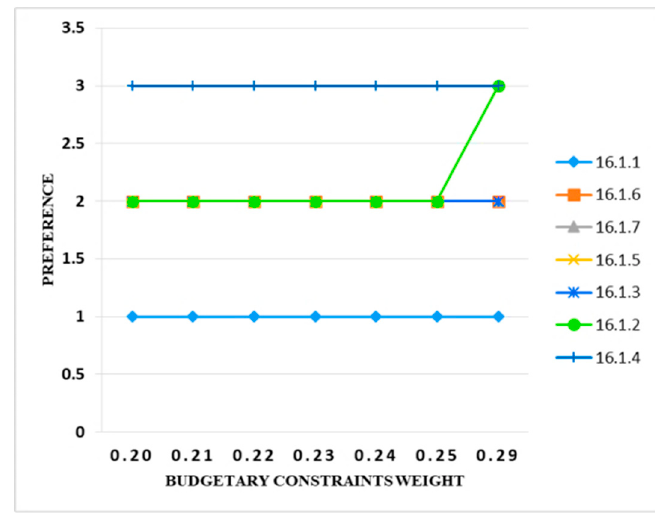
Figure 13. Sensitivity analysis of preference and budgetary constraints weight.